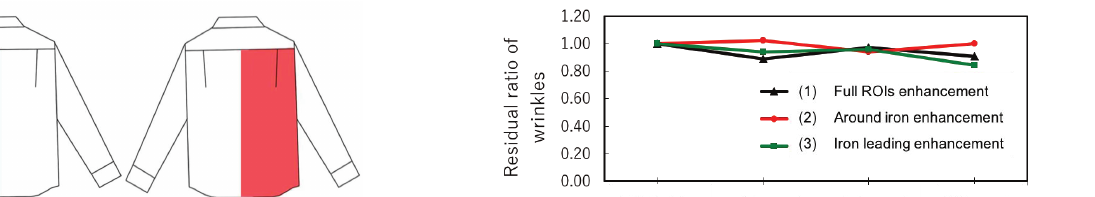
Figure 4. The target part of a shirt (red), in which left and right sides are ironed separately.